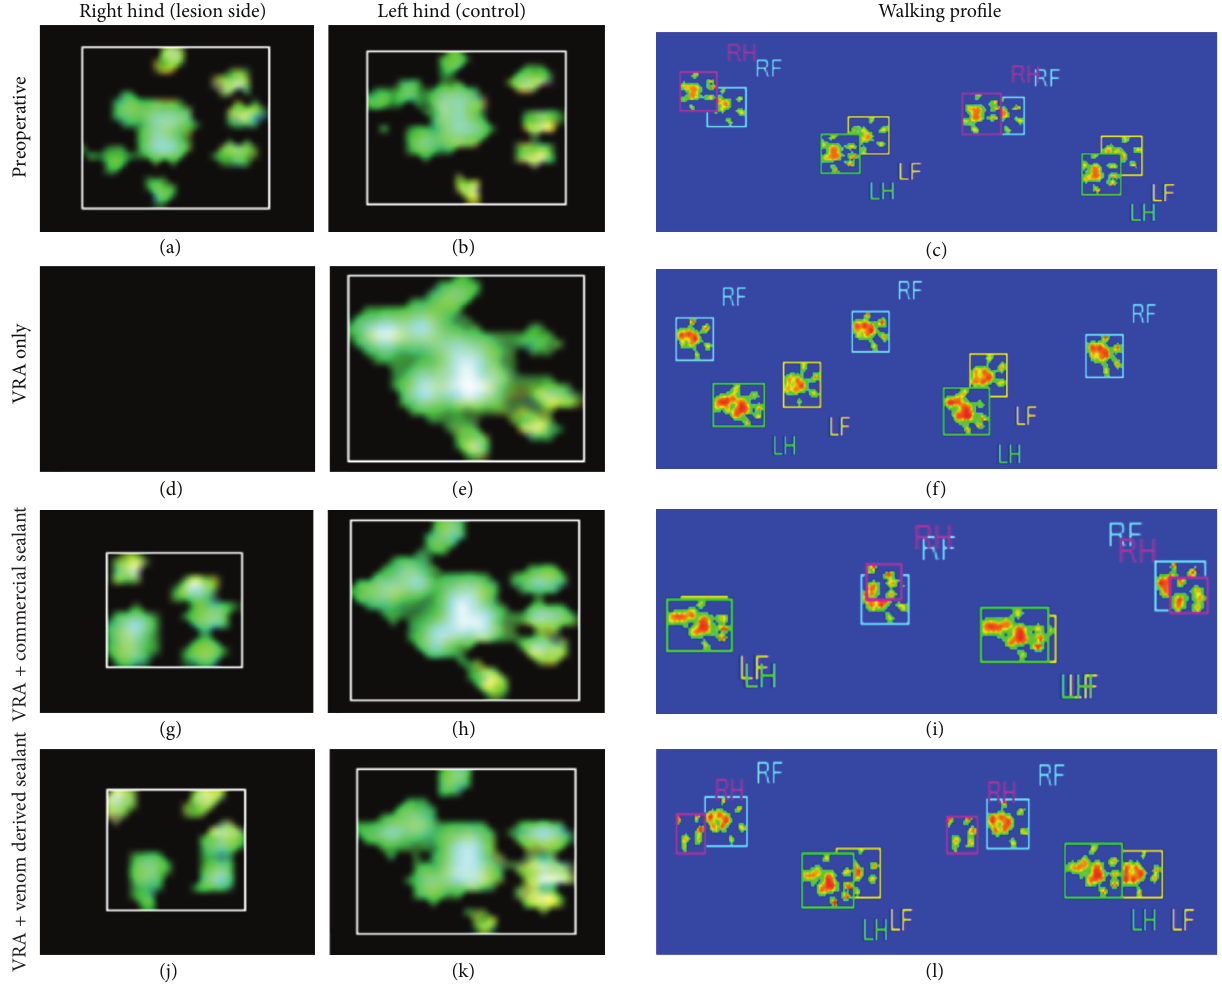
Figure 8: Paw print and walking profile, obtained with the CatWalk system, at 12 weeks after lesion. (a–c) Preoperative; (d–f) VRA Only; (g–i) VRA followed by reimplantation with fibrin sealant derived from snake venom; (j–l) ventral root avulsion followed by reimplantation with commercial fibrin sealant. Observe rats from reimplanted groups using the right paw, whereas the avulsed rat without root repair cannot control the lesioned limb. A significant restoration of weight-bearing capacity following avulsion and reimplantation with the fibrin sealants was also